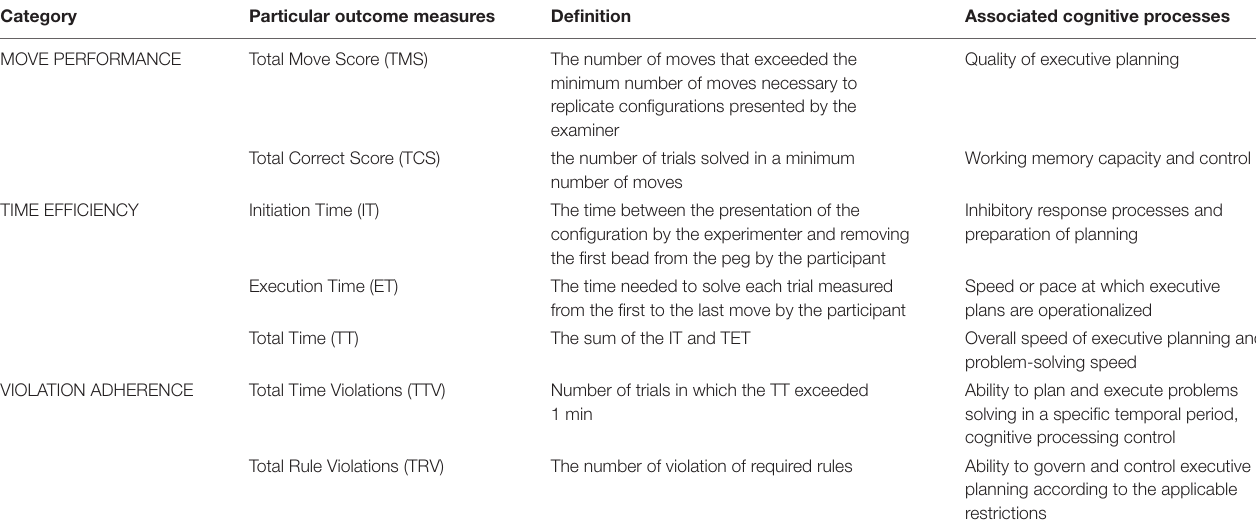
Figure 2 . The values of ISI applied in this study varied